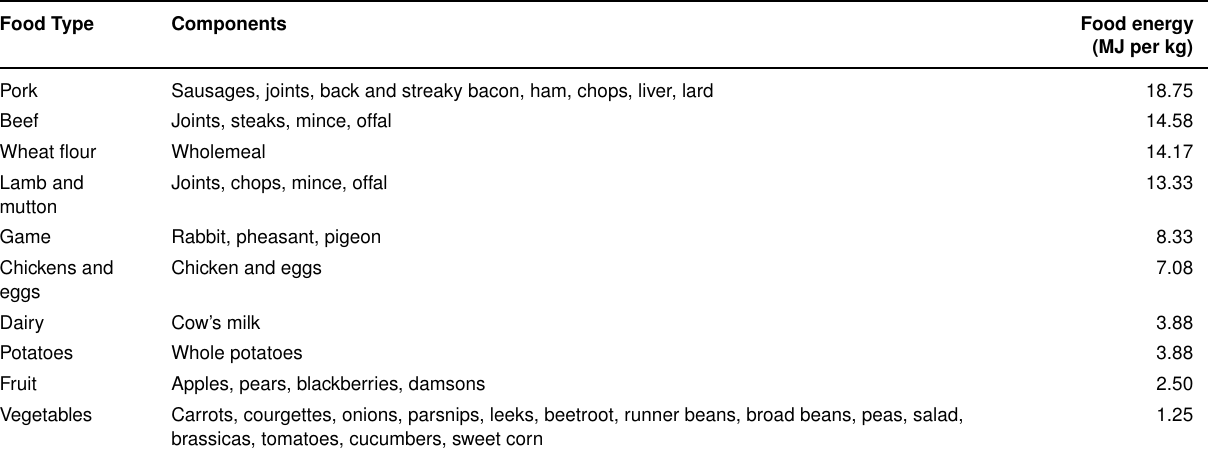
Table 2. Energy values of food types used in this study.